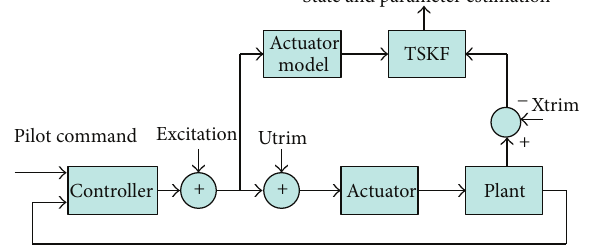
Figure 2: The overall structure of the closed-loop nonlinear B747 aircraft subject to actuator